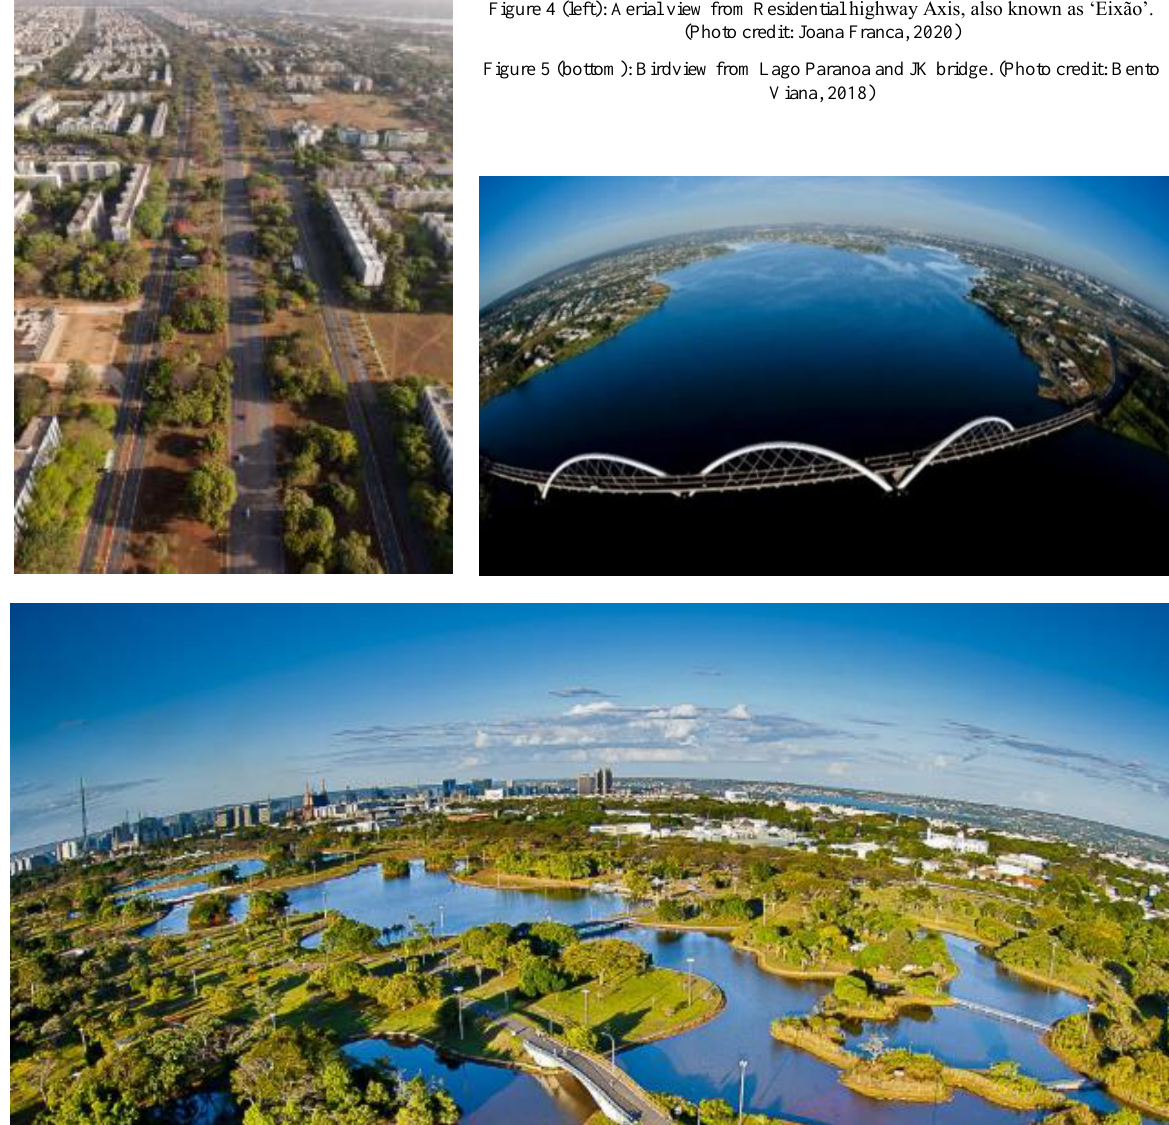
Figure 6: Birdview from City Park and its inner lakes. (Photo credit: Heitor Menezes, 2016)